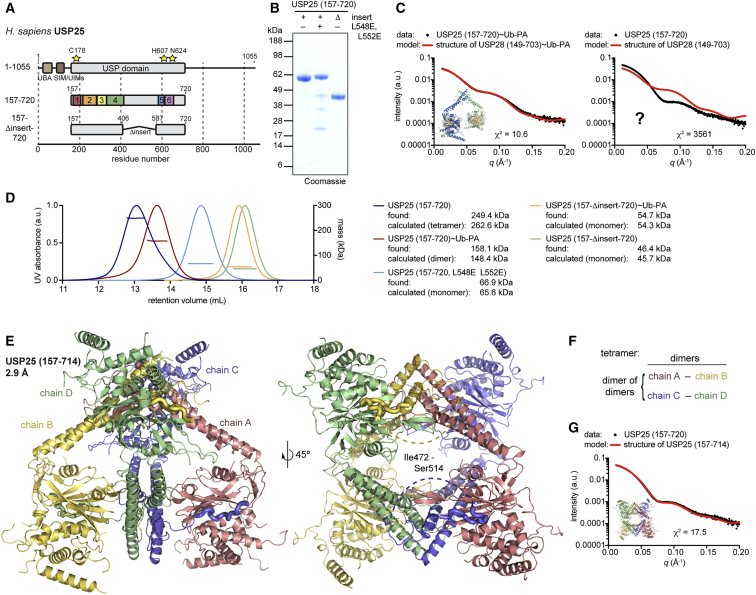
The Catalytic Domain of USP25 Is Tetrameric(A) Schematic representation of human USP25 constructs as in Figure 1A. A construct ending at residue 714 was used for crystallization.(B) Coomassie-stained SDS-PAGE gel of indicated recombinant proteins.(C) SAXS data (black) collected from indicated USP25 protein samples and overlaid with expected scattering curves (red) calculated from USP28 crystal structures, indicating the distinct scattering of apo USP25.(D) SEC-MALS analysis of indicated USP25 proteins. Identified masses are matched to either monomeric (light colors) or multimeric (dark colors) expected masses.(E) Crystal structure of the catalytic domain of USP25 in two orientations. Chains A and B constitute the asymmetric unit, and chains C and D are shown from symmetry-related molecules. Residues 515–528, which contact the catalytic domain of adjacent chains, are shown as thick tubes. Dotted lines indicate disordered residues.(F) Schematic of the USP25 tetramer as dimer of dimers.(G) SAXS data (black, repeated from C for clarity) overlaid with the expected scattering curve (red) calculated from the tetrameric USP25 crystal structure.